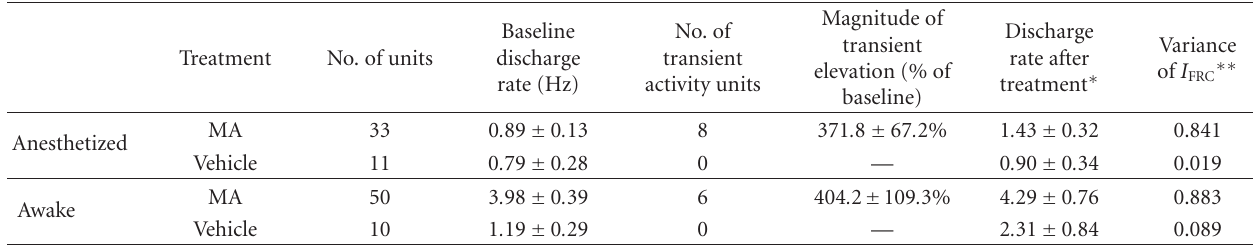
Table 1: Summary of changes in unit activity following MA or vehicle